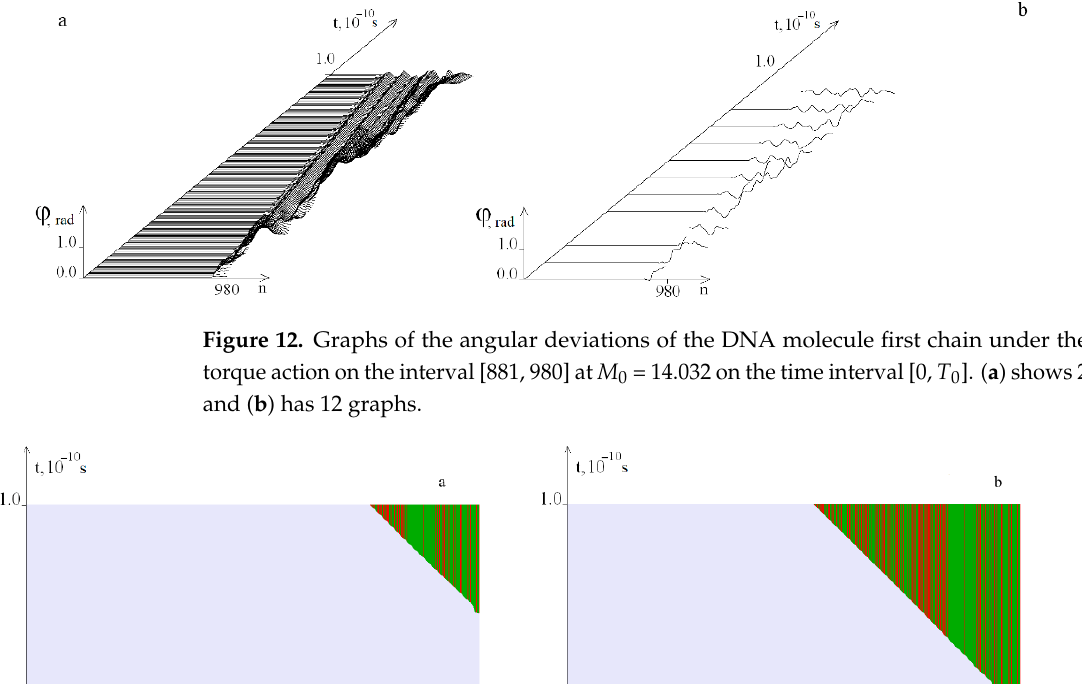
10 of 15 Figure 10. Graphs of the angular deviations of the first DNA molecule strand under the localized torque action on the interval [781, 880] at M 0 = 15.045 on the time interval [0, T 0 ]. Figure 10a shows 200 graphs and 10b has 12 graphs. Figure 11 shows OS regions under the localized torque action on the segment [781, 880]. It can be seen, that the occurrence of OS when the torque is localized in the area rich with A – T pairs begins at lower values of the M 0 opposite torque localization on the seg- ments [1, 100] and [101, 200]. Figure 11. OS regions arising under the localized torque action on the segment [781, 880] (a — at M